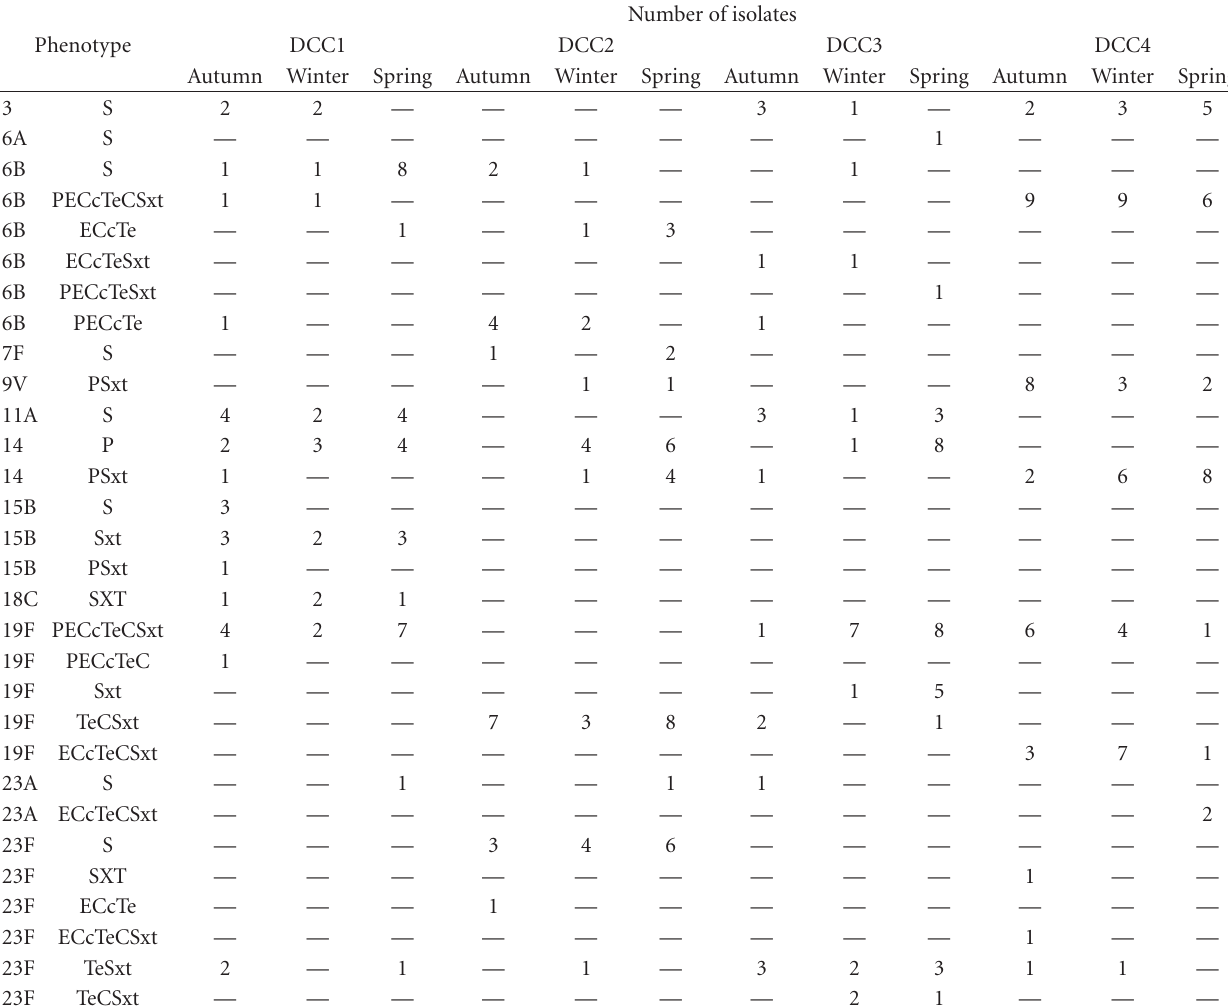
Table 3: Dynamics of phenotype prevalence of S. pneumoniae isolates in healthy preschool children in DCCs in following